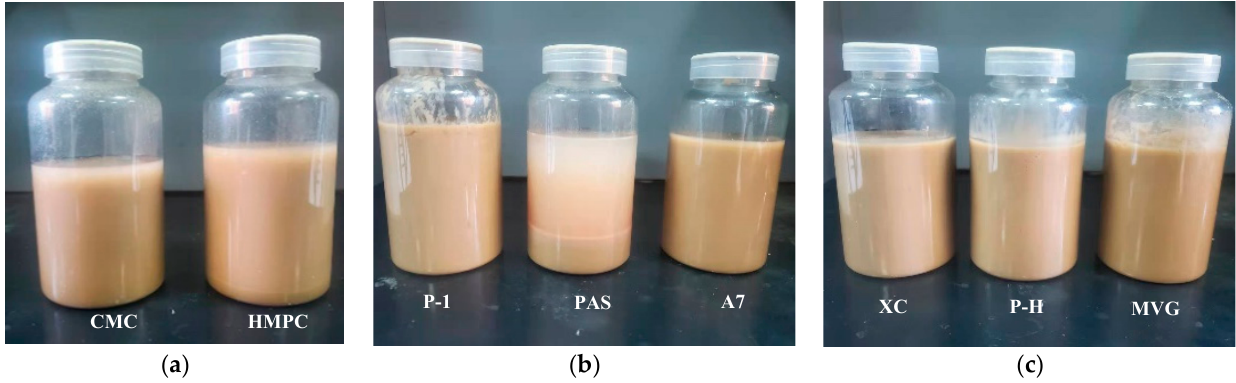
Figure 1. Apparent viscosity of the sea salt slurries containing 0.5% of the examined polymers.